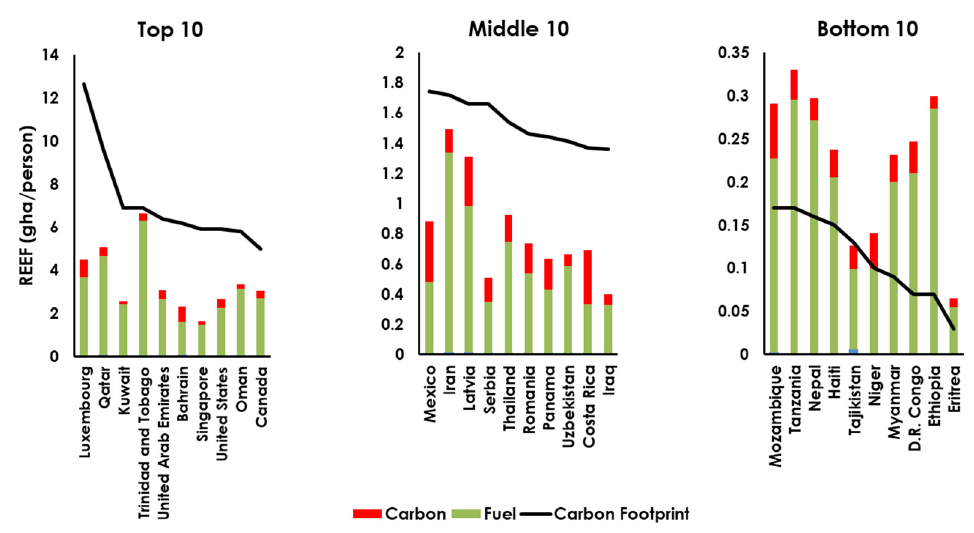
Figure 6. Comparison of REEF and carbon footprints for top 10, middle 10 and bottom 10 countries (ordered by carbon footprint).